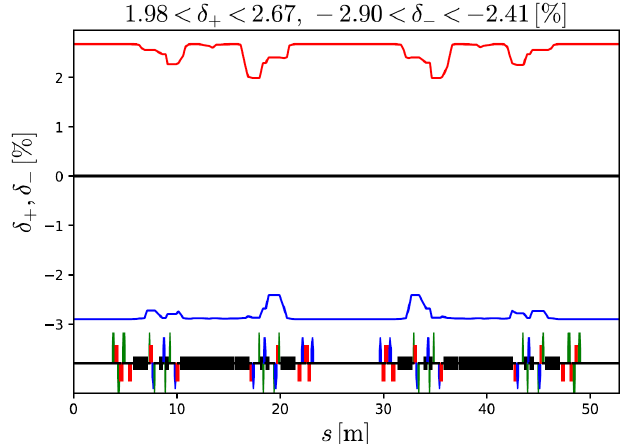
FIG. 11. 6D Momentum acceptance for the octupole setup ð w oct ; C ; w oct ; H Þ ¼ ð 70% ; 30% Þ , tracked along one super-cell for 2048 turns. An rf cavity was turned on with harmonic number of 1320 and rf bucket height of 2.73%. Radiation loss was